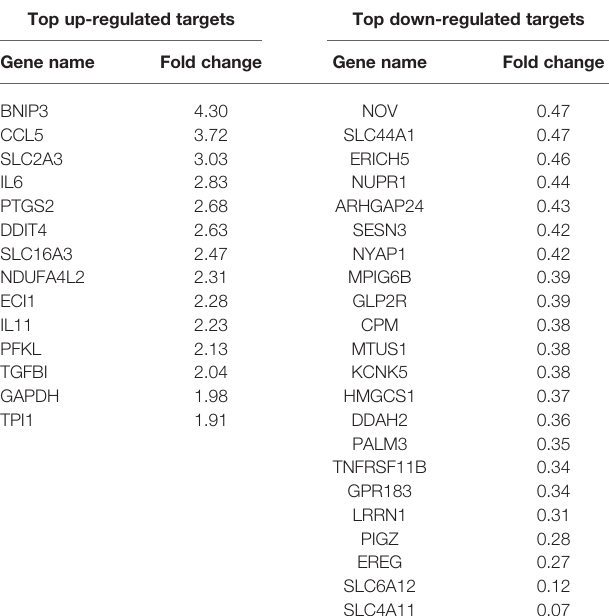
TABLE 5 | RNA sequencing: top up- and down-regulated genes in bovine NP cells with FDR < 0.05 and p-value < 0.05 for 24 h of hypo-osmotic versus iso- osmotic